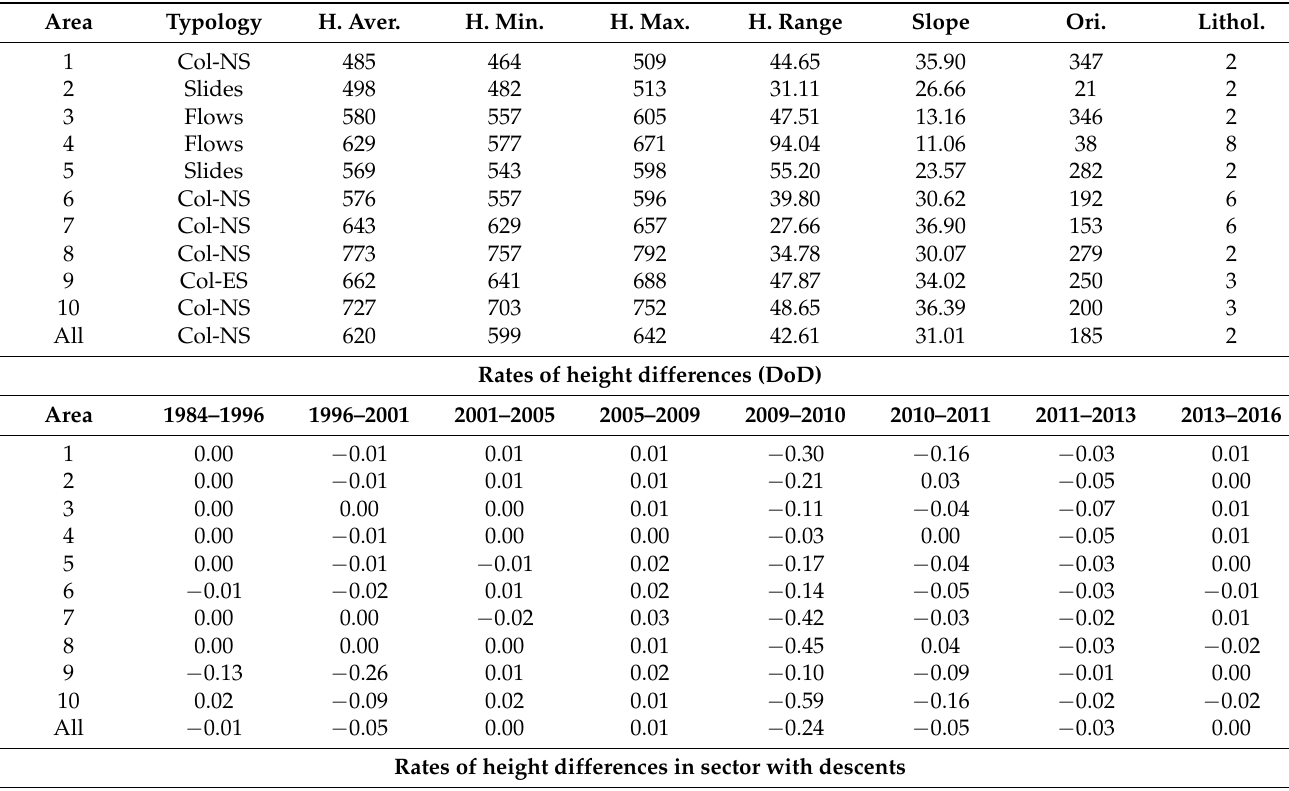
Table 6. Analysis of the monitoring